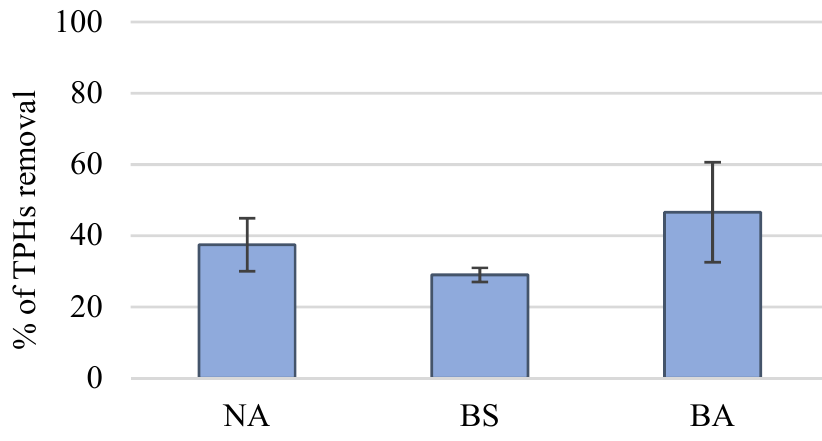
Figure 5. Removal percentage of total petroleum hydrocarbons (TPHs) in the microcosm experiments (mean value, standard deviation, n = 3) for the different treatments: natural attenuation (NA), biostimulation (BS) and bioaugmentation (BA).